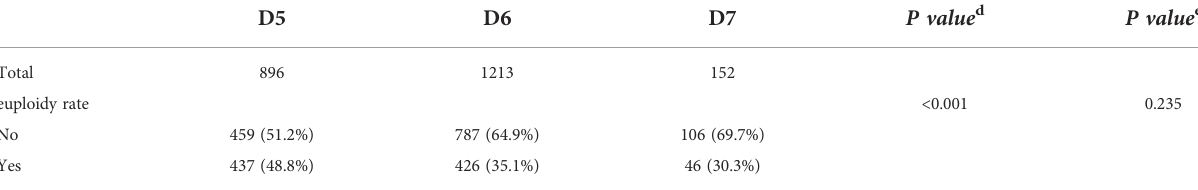
d represents the comparison between D5 and D7 blastocysts, e represents the comparison between D6 and D7